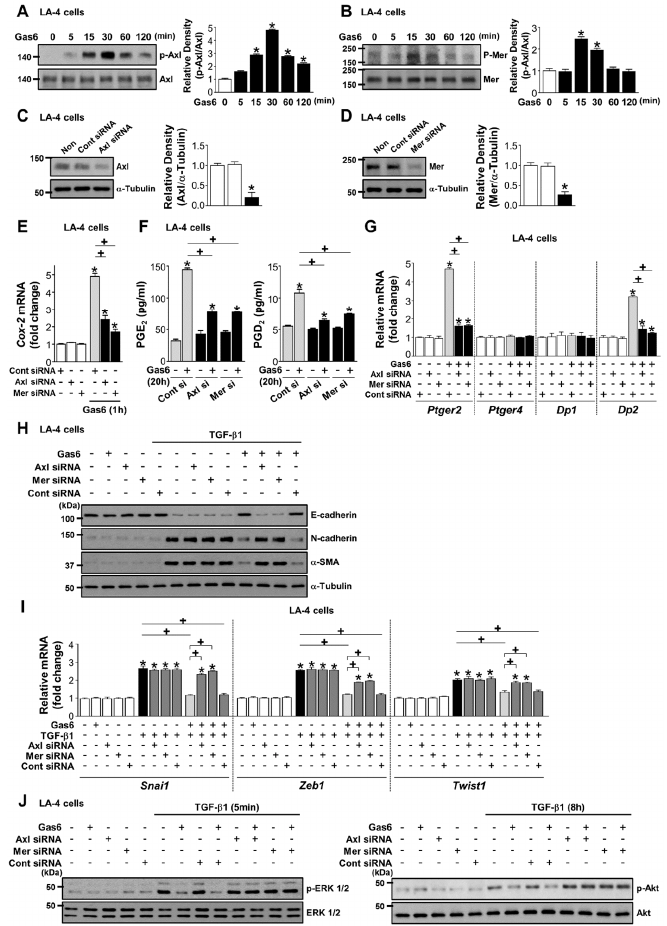
Figure 6. Activation of Axl or Mer mediates growth arrest-specific protein 6 (Gas6)-induced inhibition of COX-2 signaling and epithelial-mesenchymal transition (EMT) in LA-4 epithelial cells (ECs). ( A , B ) Immunoblot of total cell lysates were performed with anti-total / phosphorylated Axl and -Mer antibodies in LA-4 ECs treated with 400 ng / mL Gas6 for the times indicated. Densitometric analysis of the indicated protein abundances. ( C , D ) Immunoblots of total cell lysates were performed with anti-Axl, or -Mer antibodies in LA-4 ECs transfected with Axl, Mer, or control siRNA. Densitometric analysis of the indicated protein abundances. ( E – G ) LA-4 ECs were transfected with Axl, Mer, or control siRNAs for 48 h and then stimulated with 400 ng / mL Gas6. ( E , G ) qPCR analysis of the mRNAs of Cox2, Ptger2, Ptger4, Dp1, and Dp2 in LA-4 EC lysates 1 or 20 h after Gas6 stimulation. ( F ) PGE 2 and PGD 2 levels in conditioned media 20 h after Gas6 stimulation were measured by enzyme immunoassay.